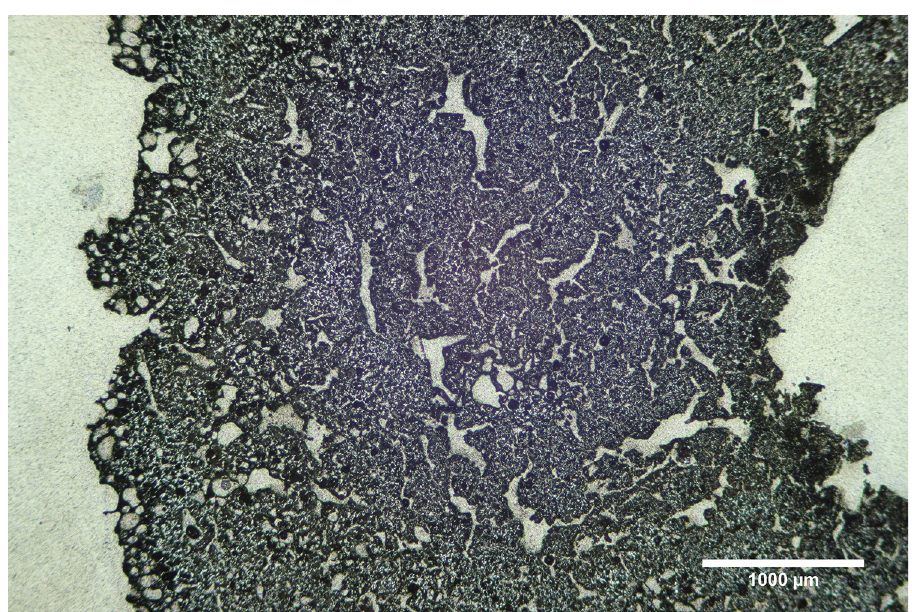
Fig 8. Photomicrograph of M-55 showing heat exposure on exterior. Photomicrograph of sample M-55 in reflected light showing the larger amount of vitrification and bloating along the exterior of the tip as compared to the area near the central hole. Photomicrograph by Jennifer